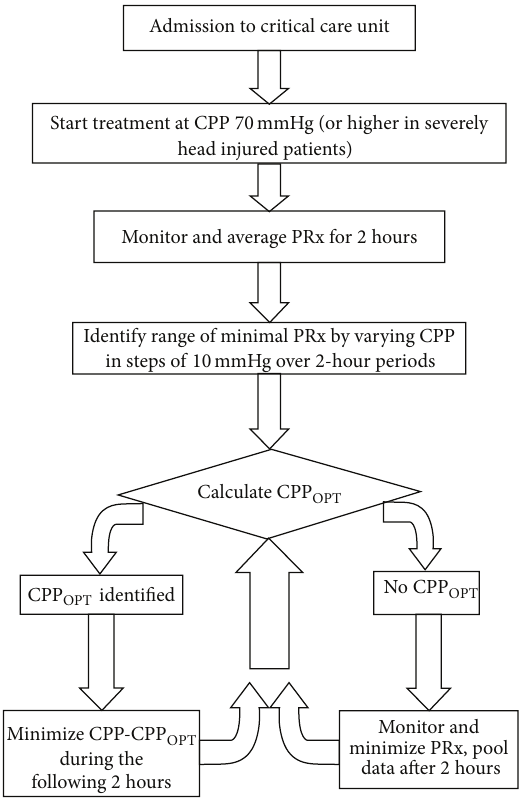
Figure 7: An algorithm to trace the PRx/CPP curve. CPP: cerebral perfusion pressure. PRx: pressure reactivity index.